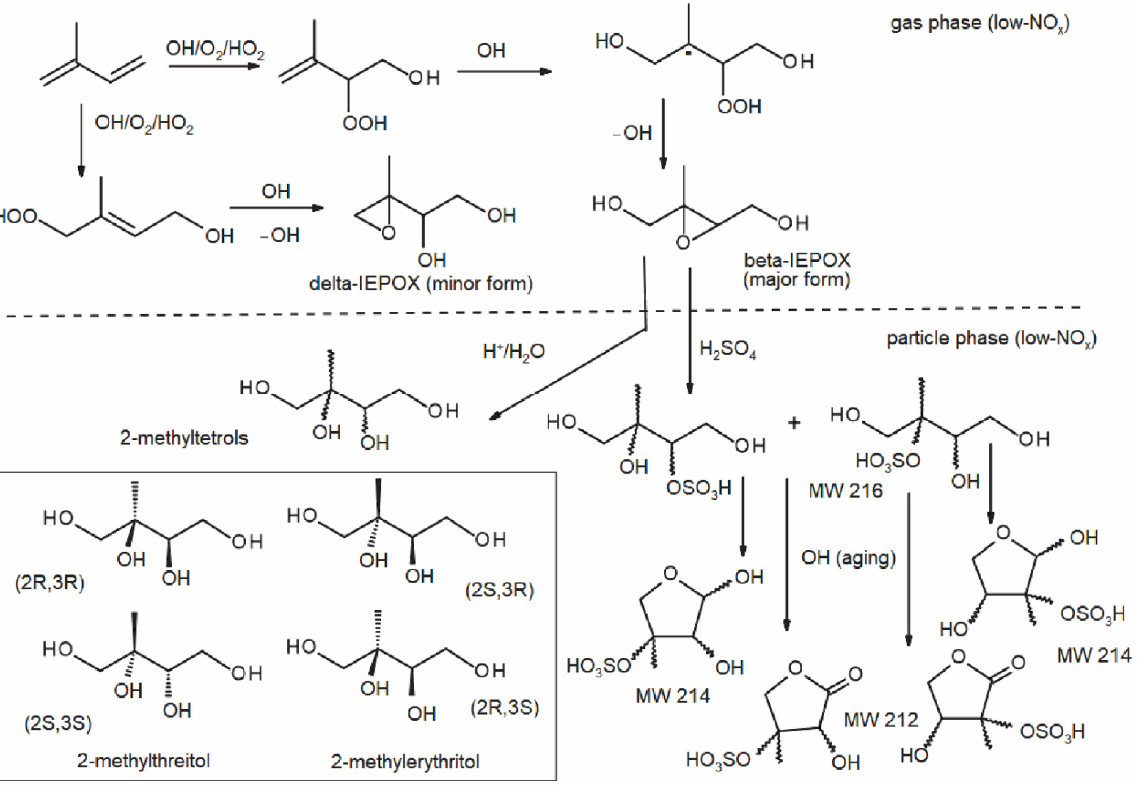
Figure 1. Formation pathways of isoprene SOA at low-NO x . For simplicity, only dominant pathways are presented. Dimers and degradation products of methyltetrol organosulfates (e.g., C 5 -alkene triols) are not included (adapted from Surratt et al., 2010 [6]). The four stereoisomeric forms of the 2-methyltetrols are shown in the box; the 2-methyltetrols occur in two diastereoisomeric forms, 2-methylthreitol and 2-methylerythritol, and each of them has two enantiomers. Also shown are MW 212 and 214 organosulfates, formed by further processing of 2-methyltetrol-related MW 216 organosulfates.